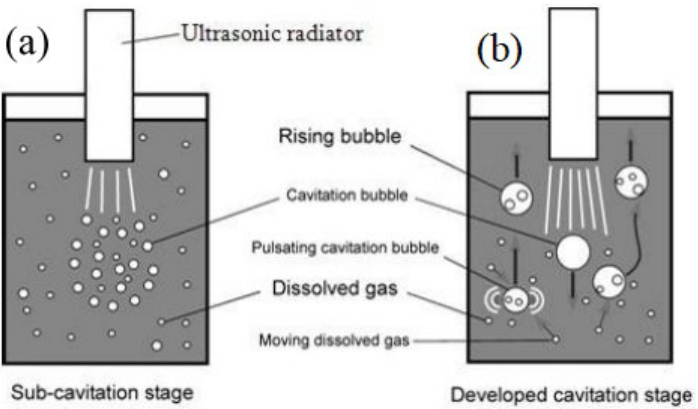
Figure 4. Two different cavitation stages. ( a ) Sub-cavitation stage; ( b ) developing/developed cavitation stage.